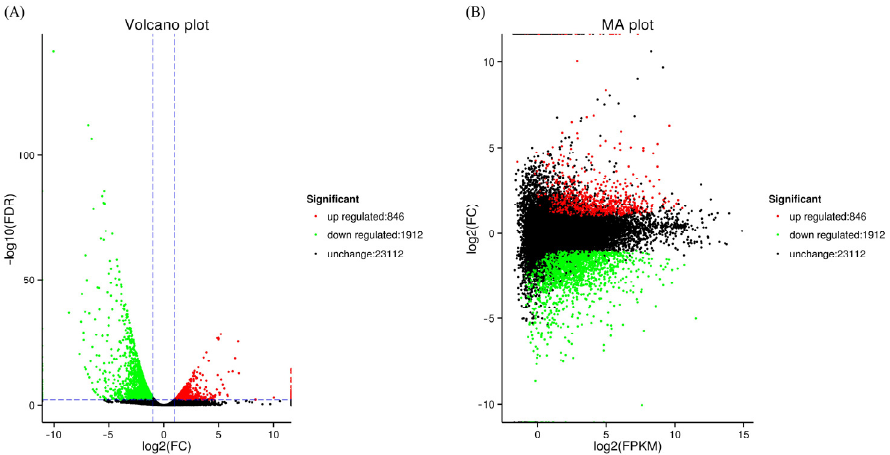
Figure 2. Differentially expressed genes in treatment and control groups. Note: Panels ( A , B ) display the comparison of the two groups using a volcano plot and a MA plot, respectively. Red dots represent genes that are strongly up-regulated, green dots represent significantly down-regulated genes, and the absence of black dots indicates that the gene expression was unaffected.